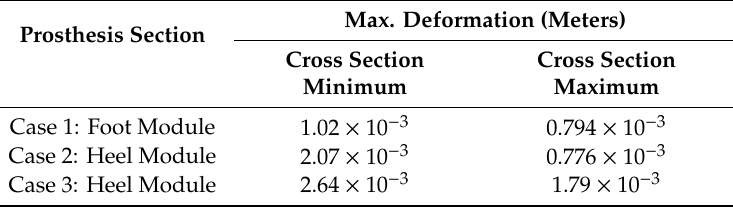
Table 3. Maximum deformations.